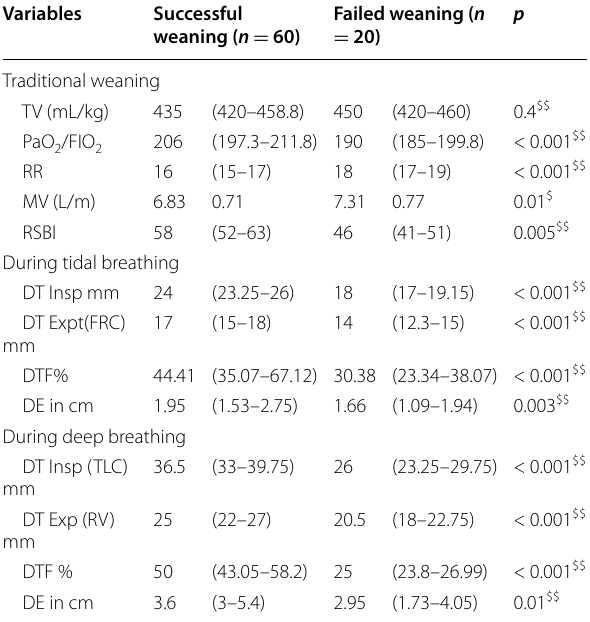
Table 1 Comparison between patients with successful and failed weaning as regards traditional weaning indices and new diaphragmatic parameters